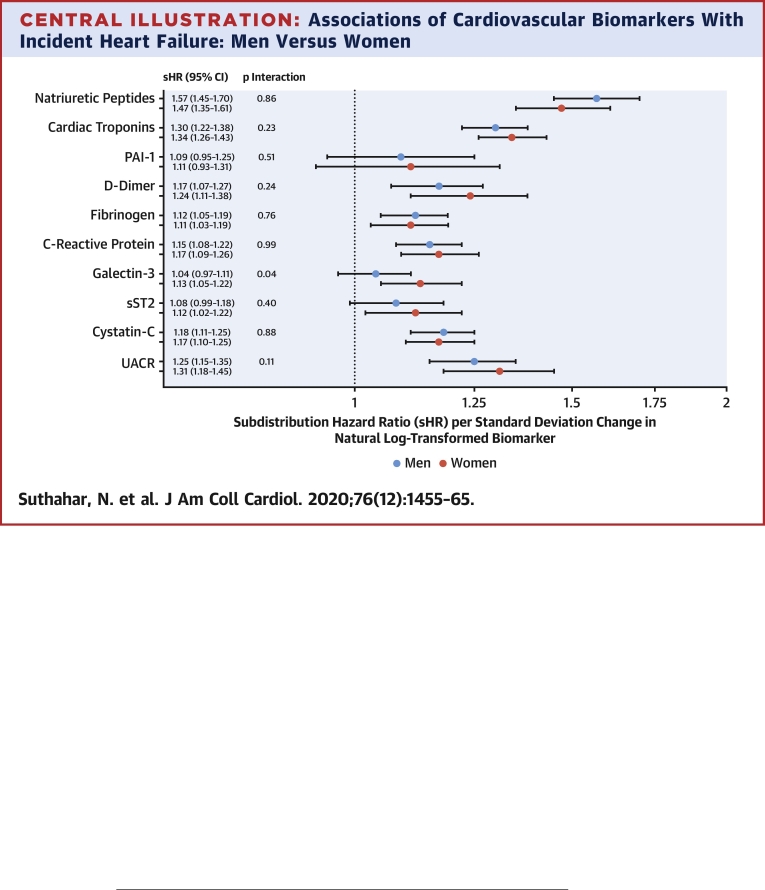
Associations of Cardiovascular Biomarkers With Incident Heart Failure: Men Versus WomenAssociations of individual biomarkers with incident heart failure were evaluated using Fine-Gray models adjusting for the competing risk of death, and for the following variables: age, smoking, diabetes mellitus, hypertension, body mass index, atrial fibrillation, myocardial infarction, and presence of left ventricular hypertrophy/left bundle branch block. Natriuretic peptides include N-terminal pro–B-type natriuretic peptide or B-type natriuretic peptide. Cardiac troponins include cardiac troponin-T or I. Interaction p value denotes sex•covariate interaction on a multiplicative scale in the total population. None of the biomarkers displayed a significant interaction with sex for heart failure outcome. CI = confidence interval; PAI = plasminogen activator inhibitor; sHR = subdistribution hazard ratio; sST2 = soluble interleukin-1 receptor-like 1; UACR = urinary albumin-to-creatinine ratio.